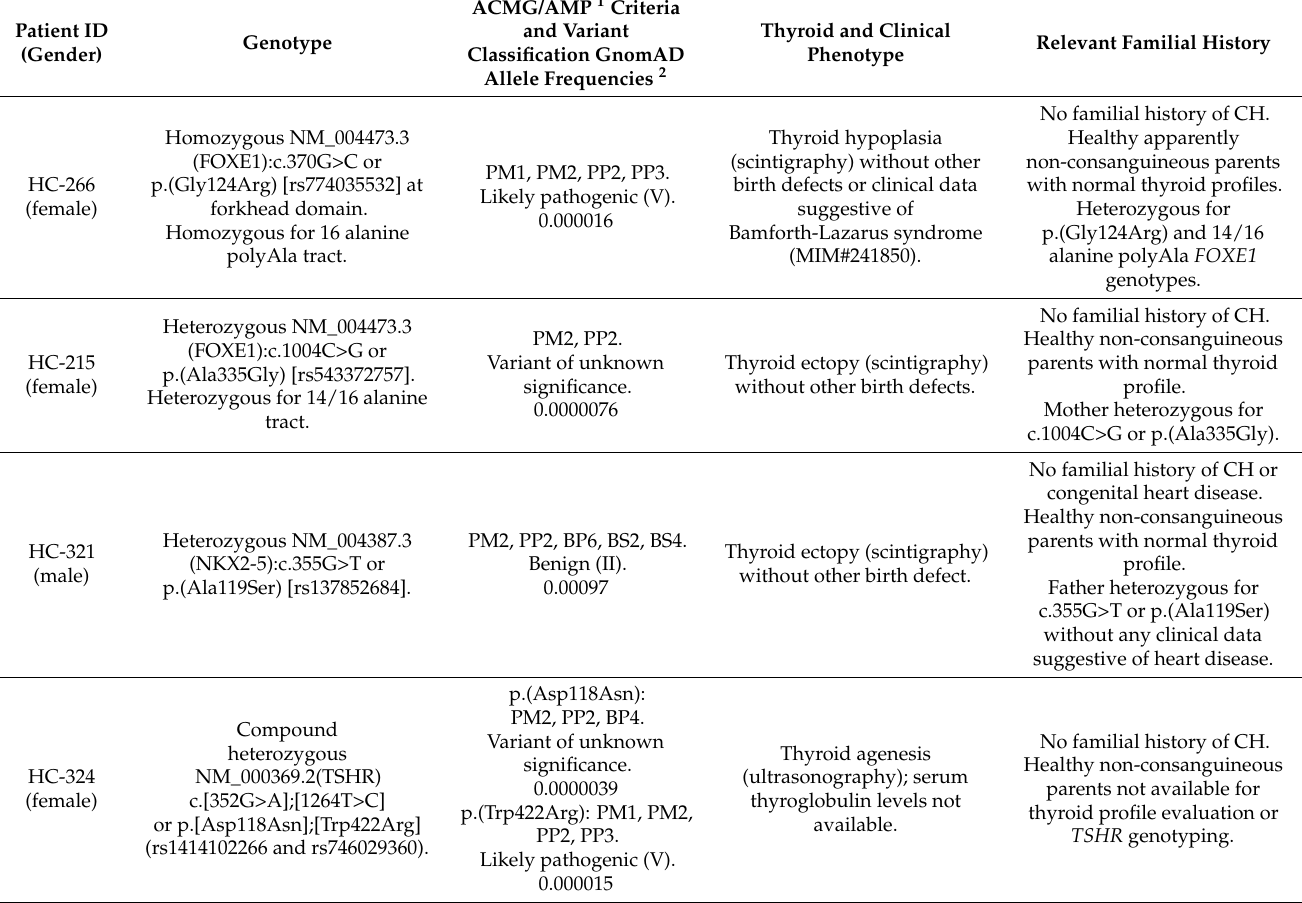
Table 1. Genotypic and clinically relevant data identified by Sanger sequencing of NKX2-5 , FOXE1 , and TSHR genes among 128 Mexican unrelated CH-TD